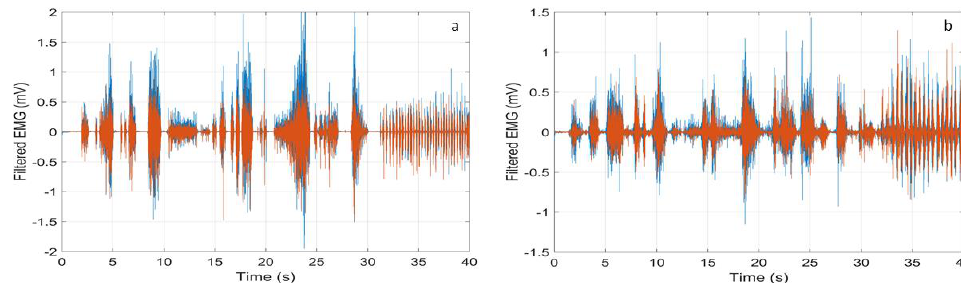
Figure 11. Filtered sEMG signal during random contractions of the tibialis anterior ( a ) and the gastrocnemius muscle ( b ) recorded by the Digitimer D360 with the Notch filter deactivated (blue curve) and by our wearable device (red curve).